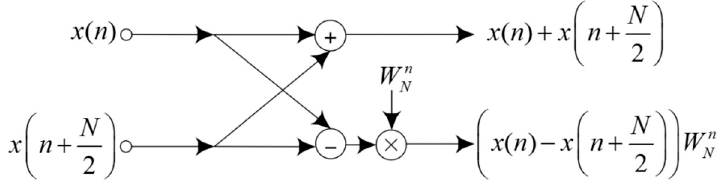
Figure 1. A radix-2 butterfly unit of the radix-2 decimation in frequency (R2DIF) algorithm.